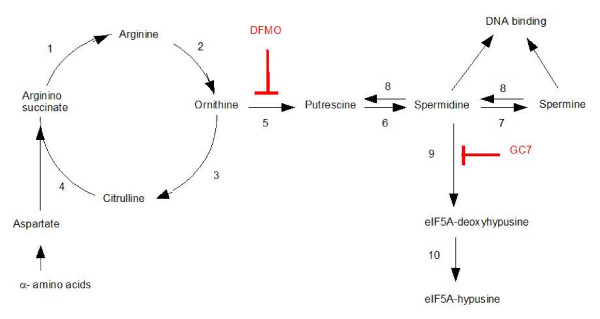
The synthesis of polyamines and the hypusination of eIF5A. Enzymes are: arginosuccinate lyase (1), arginase (2), ornithine carbamoyl transferase (3), arginosuccinate synthase (4), ornithine decarboxylase (ODC) (5), spermidine synthase (6), spermine synthase (7). Spermine synthase and spermidine synthase also require decarboxylated S-adenosylmethionine which is produced by S-adenosylmethionine decarboxylase. Polyamines catabolism (8) is achieved by spermine/spermidine N1-acetyltransferase and a peroxisomal flavoprotein polyamine oxidase. The formation of hypusine (Nε-(4-amino-2-hydroxybutyl)lysine) occurs in two steps. Deoxyhypusine synthase (9) transfers the 4-aminobutyl moiety of spermidine to the ε-amino group of a specific lysine residue of eIF5A. Deoxyhypusine hydroxylase (10) hydroxylates eIF5A-deoxyhypusine. In yeast and mammals, only hypusinated forms of eIF5A are active. DFMO inhibits ODC, the rate limiting enzyme for polyamine synthesis. GC7 inhibits deoxyhypusine synthase (DHS). The polyamines synthetic enzymes, ODC and S-adenosylmethionine decarboxylase are up regulated in response to a decrease in polyamines. Spermine/spermidine N1-acetyltransferase which mediates the retroconversion of polyamines is up regulated by spermine and spermidine.